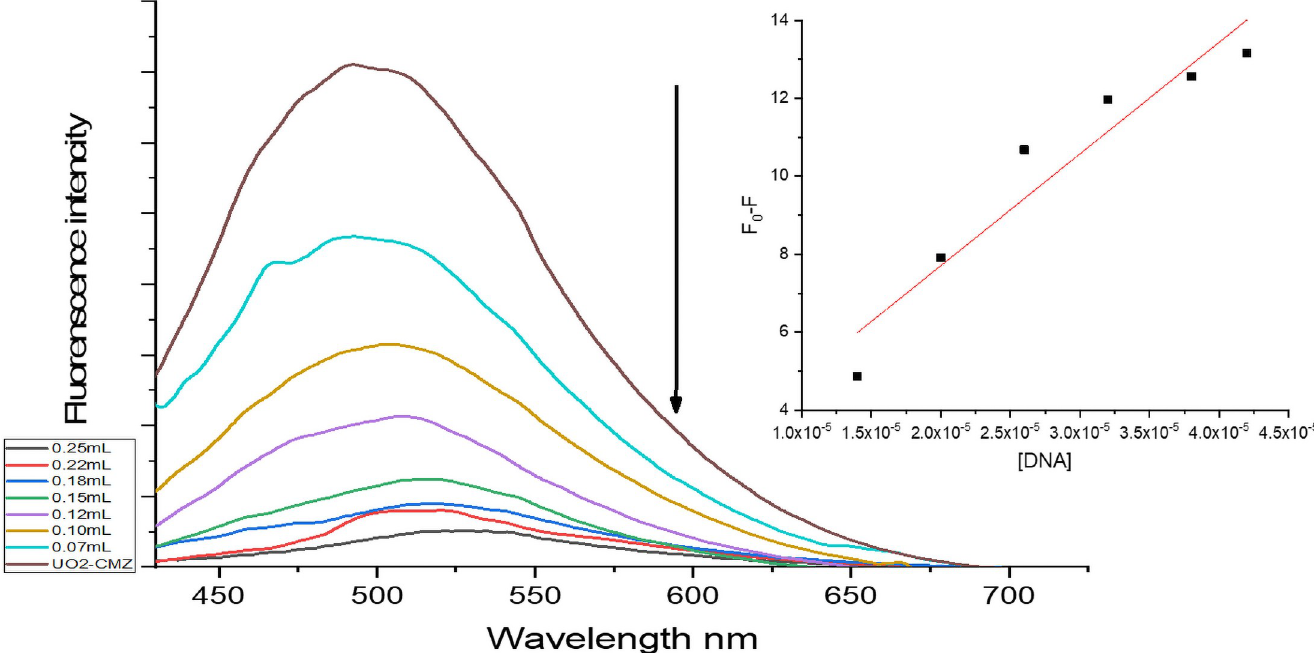
Fig 8. Emission spectra of [(UO 2 )(OAc) 2 (CMZ)] complex in Tris–HCl buffer in the absence and presence of CT–DNA. The arrow shows the intensity change upon increasing CT–DNA concentrations.